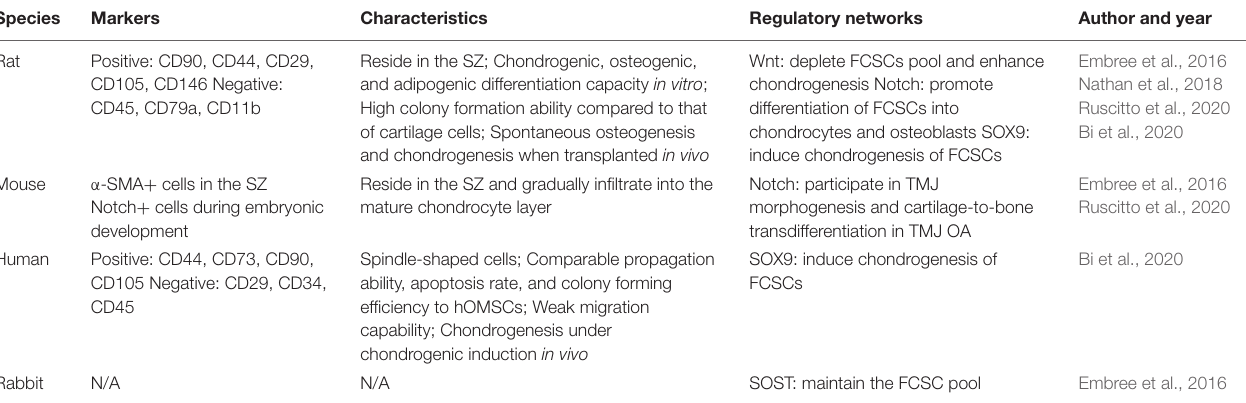
TABLE 1 | Characteristics and regulatory networks of FCSCs in animals and humans. Species